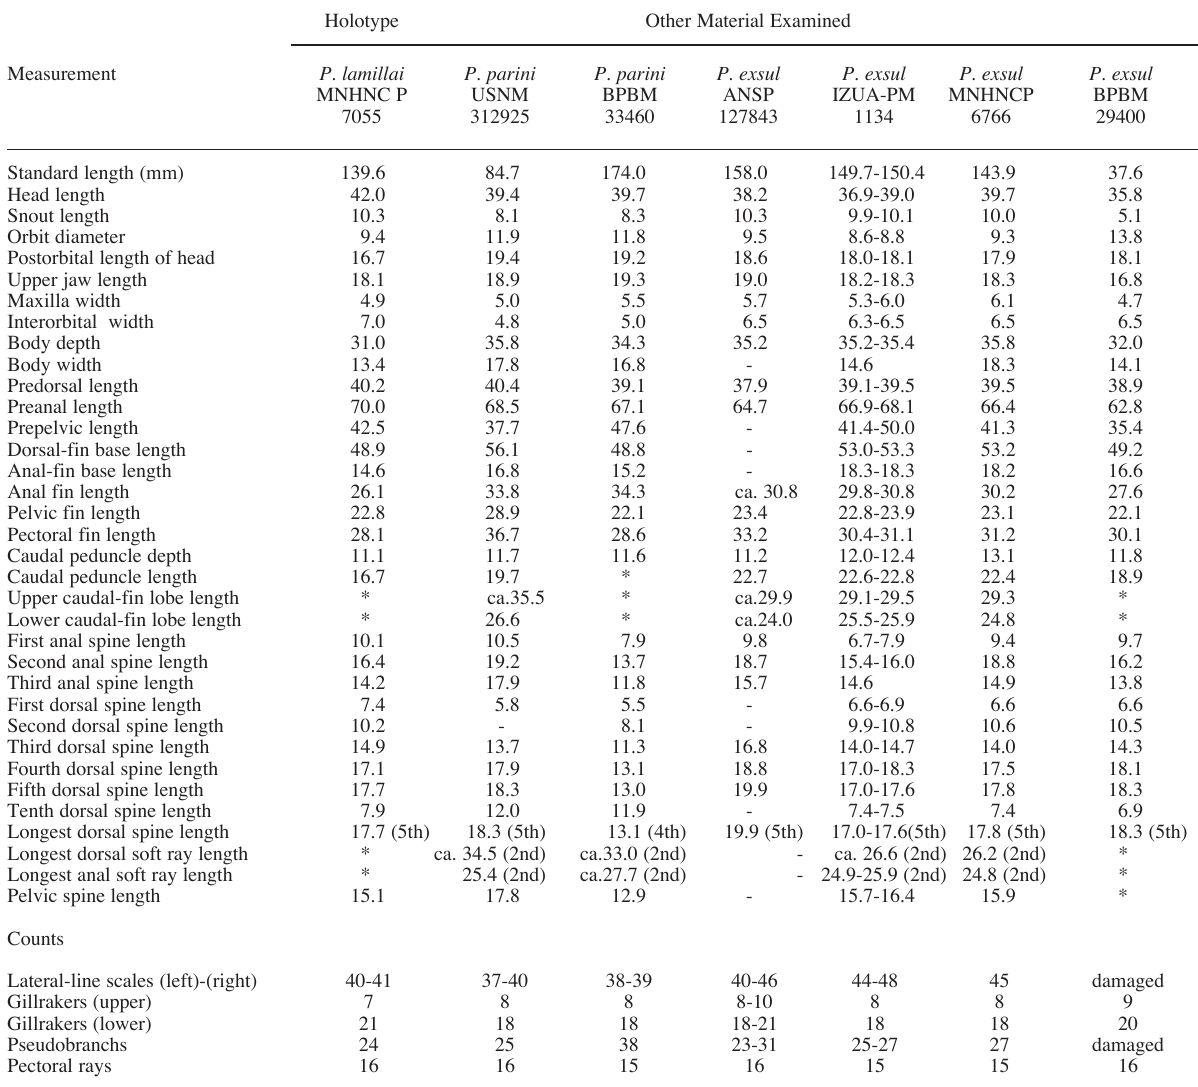
Vomerine teeth in a chevron-shaped band of about two rows; palatine teeth in two rows. Inner medial than longest gill filament. Branchiostegal rays 7. Opercle flap projecting slightly upward from region of middle opercular spine; upper spine blunt and nearly obtuse. Origin of dorsal fin above third or fourth lateral line scale. Dorsal fin single and continuous, not divided at base between spinous and soft rayed parts. Dorsal-fin base length 2 in